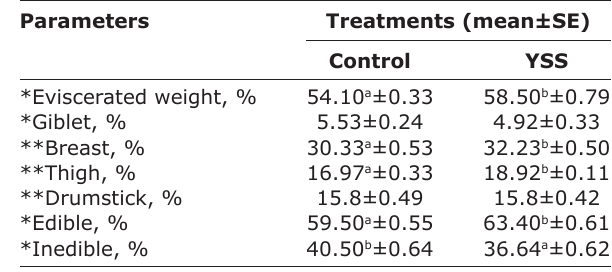
Table-3: Effect of different treatment on carcass parameter of broiler